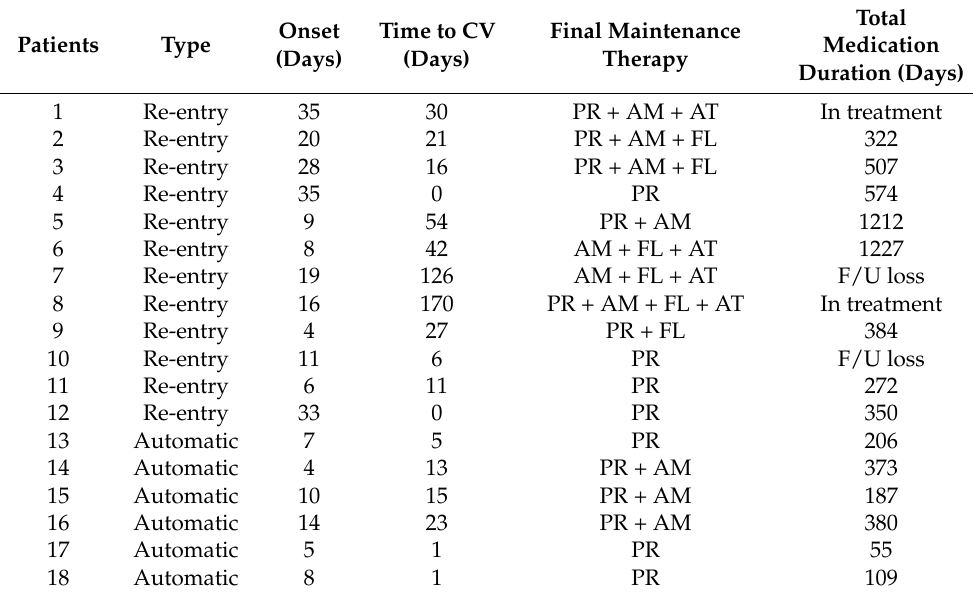
Table 3. Type of supraventricular tachycardia and medication.